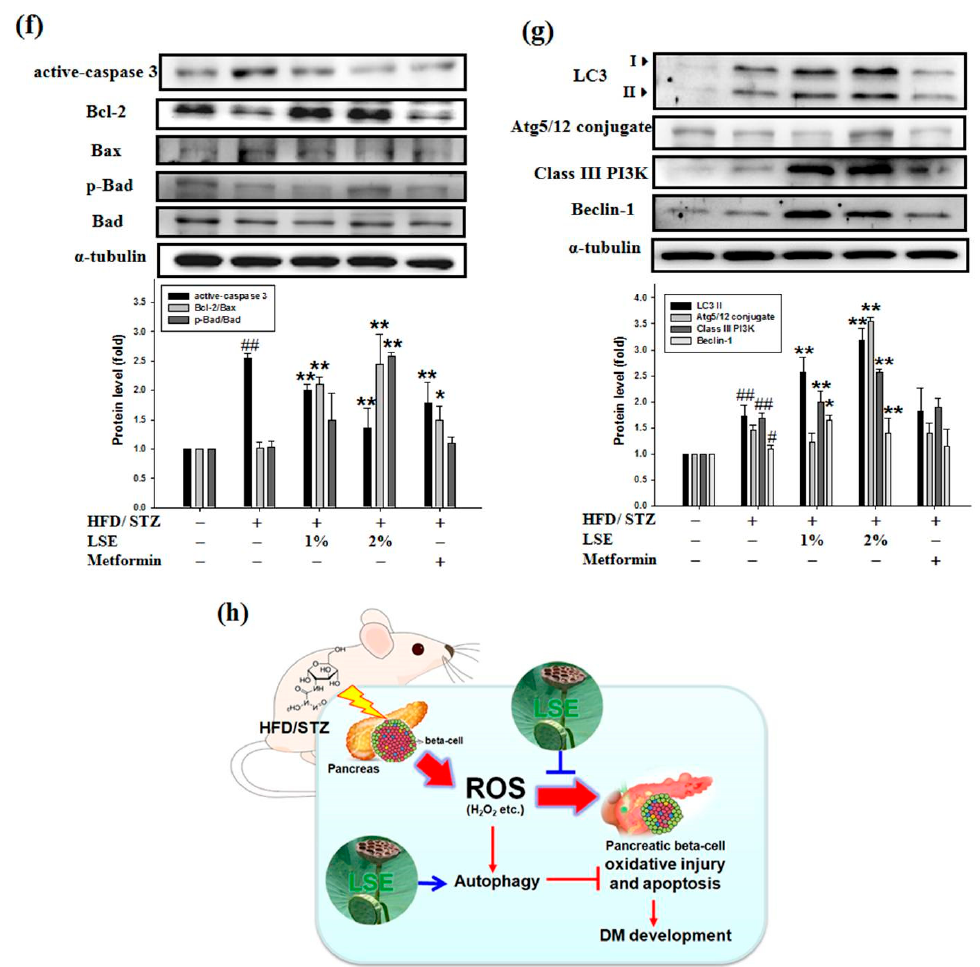
Figure 6. In vivo e ff ect of LSE on diabetes mellitus (DM) symptoms and pancreatic beta-cell dysfunction. BALB / c mice fed on a high-fat diet (HFD) combined with streptozotocin (STZ) injection (HFD / STZ) were randomly divided into four experimental groups. Among groups, two of these groups were fed with LSE at 1% and 2%, whereas the metformin group was administered intragastrically a metformin hydrochloride water solution (300 mg / kg). These mice were sacrificed after 12 weeks. The glucose tolerance ( a ) and insulin resistance ( b ) were, respectively, determined by oral glucose tolerance test (OGTT) and homeostasis model of insulin resistance (HOMA-IR). ( c ) The pancreatic tissues were collected for H&E stain ( upper panel ), and pancreatic islet apoptosis (red-brown color) was analyzed by TUNEL assay ( lower panel ). Images were taken at 200 × magnification; scale bar, 50 µ m. ( d ) The pancreatic islet areas ( left axis ), relative to the total pancreas, and apoptotic index ( right axis ) were, respectively, measured in the total islet tissues of four groups. Values are expressed as mean ± SD, n = 10; ( e ) The intracellular lipid peroxidation ( left axis ) and H 2 O 2 production ( right axis ) of pancreatic tissues were measured by TBARS and H 2 O 2 assays, respectively. ( f , g ) Western blotting of active-caspase 3, Bcl-2, Bax, p-Bad, Bad ( f ), LC3-I / II, Atg5 / 12 conjugate, class III PI3K, and Beclin-1 ( g ) protein expressions was performed with the tissue extracts from them. α -tubulin was served as an internal control. The quantitative results are expressed as the mean ± SD ( n = 10) from one independent experiment. # p < 0.05, ## p < 0.01, compared with the negative control (NC); * p < 0.05, ** p < 0.01, compared with the HFD / STZ group. ( h ) Schematic representation of in vivo beta-cell protective e ff ects of LSE against oxidative injury. HFD / STZ induces intracellular ROS production, leading to pancreatic beta-cell apoptosis and autophagy. While apoptosis contributes to cell injury (by bold arrows), autophagy is induced as a pro-survival mechanism (by regular arrows). LSE performs against ROS via the downregulation of apoptosis and upregulation of autophagy, subsequently mediating the ameliorated e ff ects on pancreatic beta-cell oxidative injury and DM